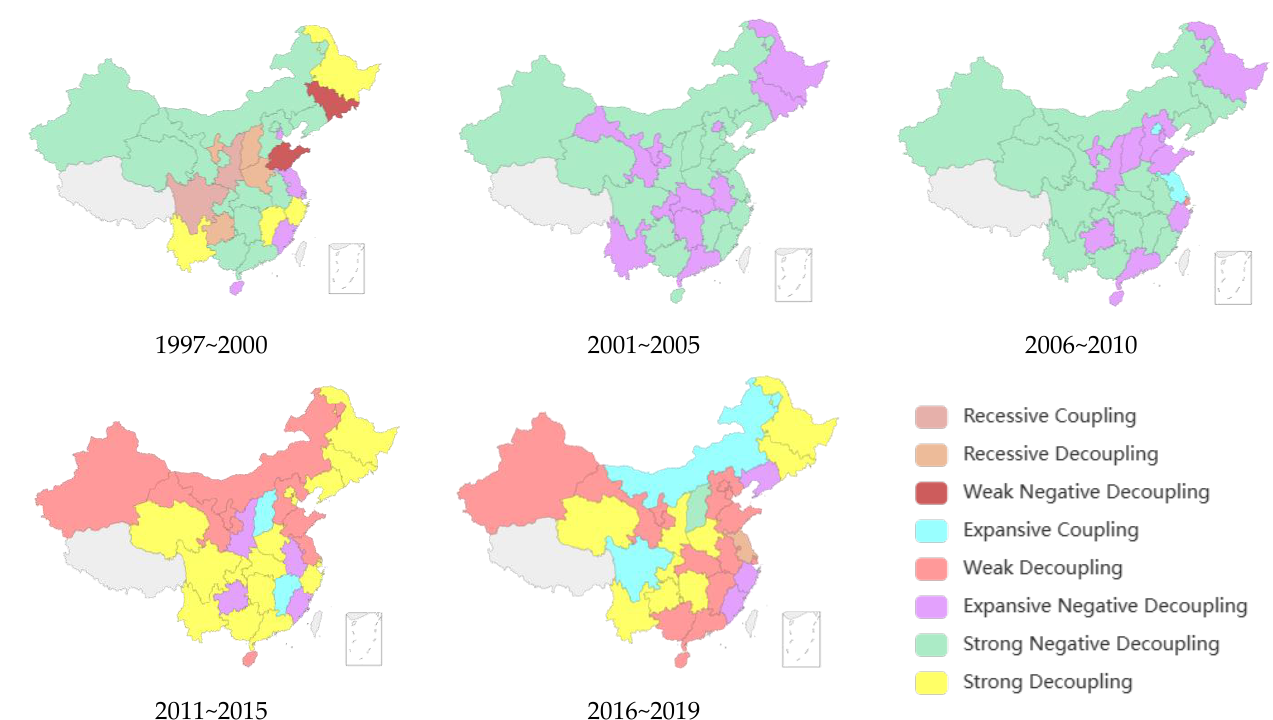
Figure 1. Evolution and distribution diagram of decoupling types.